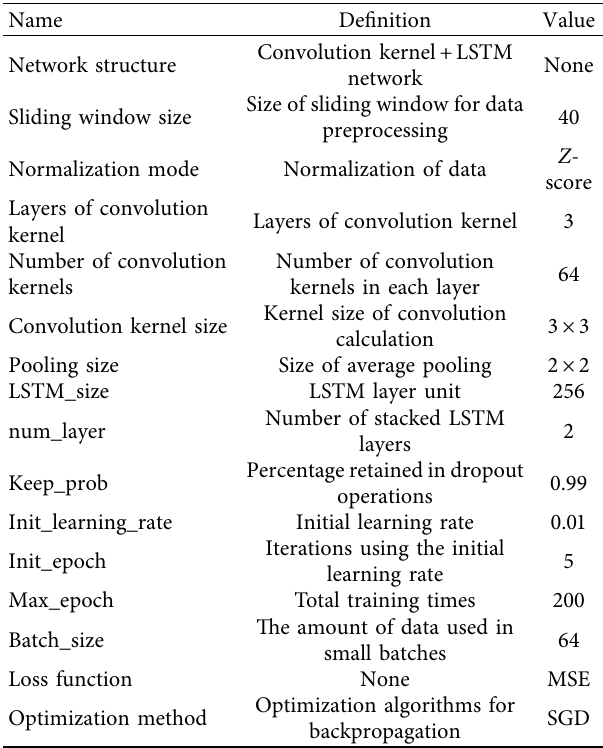
Table 4: The architecture definition of LSTM.